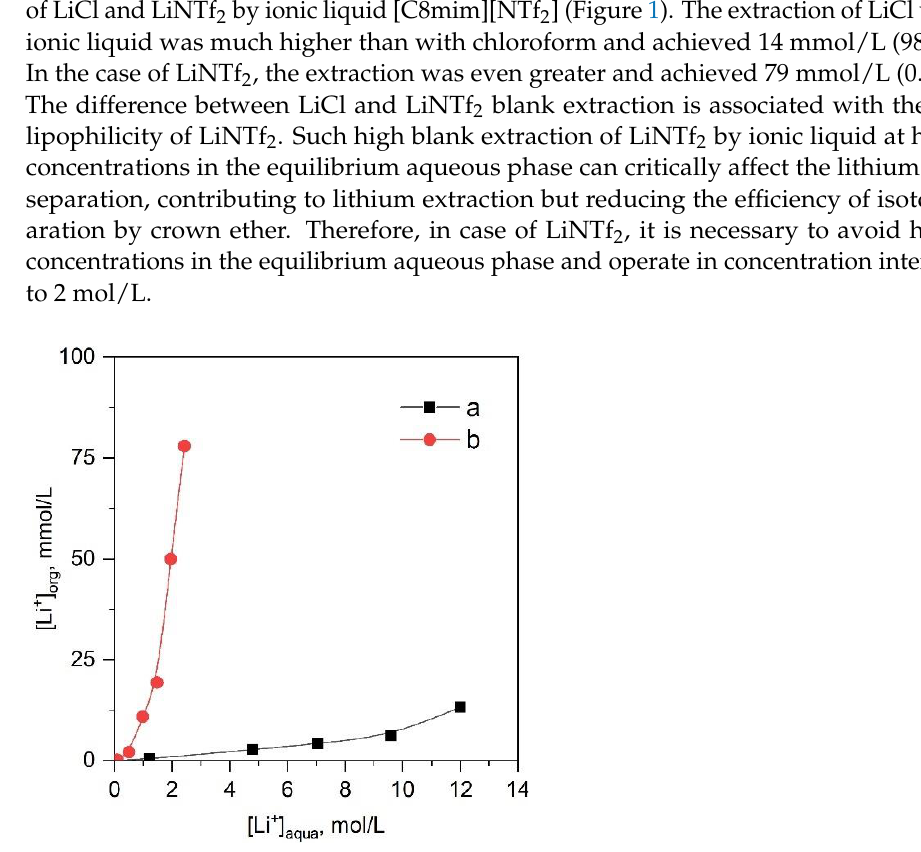
Figure 1. Blank extraction of lithium in systems: (a) LiCl-[C8mim][NTf 2 ], (b) LiNTf 2 -[C8mim][NTf 2 ]. O/A = 1, T = 23 ± 2 °C.